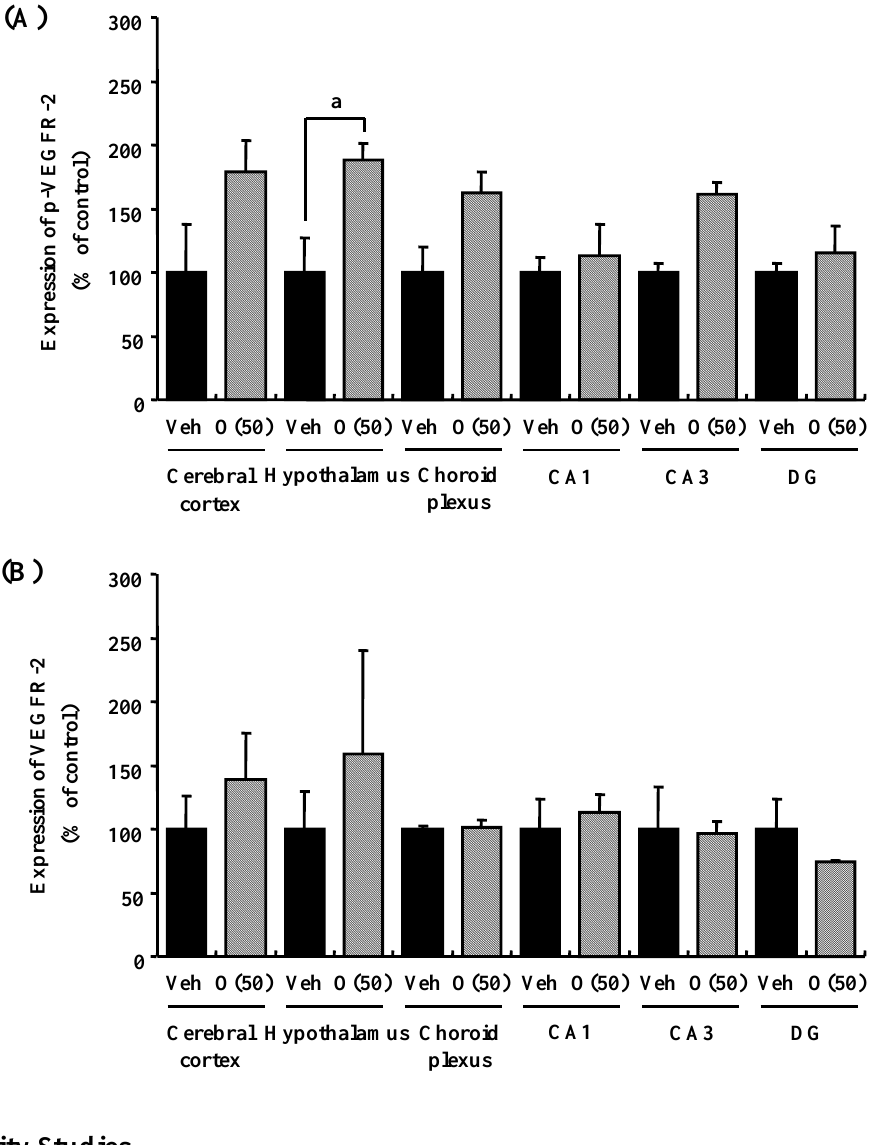
Figure 11. Intensities of p-VEGFR-2- ( A ) and VEGFR-2 ( B )-positive areas were quantified in the cerebral cortex, hypothalamus and choroid plexus, and the CA1, CA3, and DG of the hippocampus. a p = 0.0429 vs. O (50) (Student’s t -test).